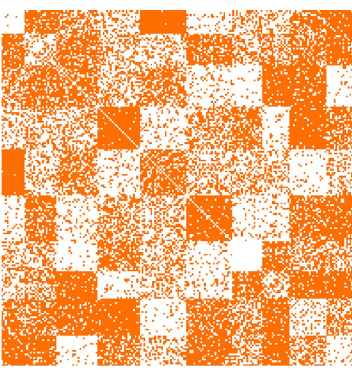
Fig. 4 Adjacency matrix of a random graph with k = 10 , and equal size blocks, generated from the same model as in previous picture but with only 200